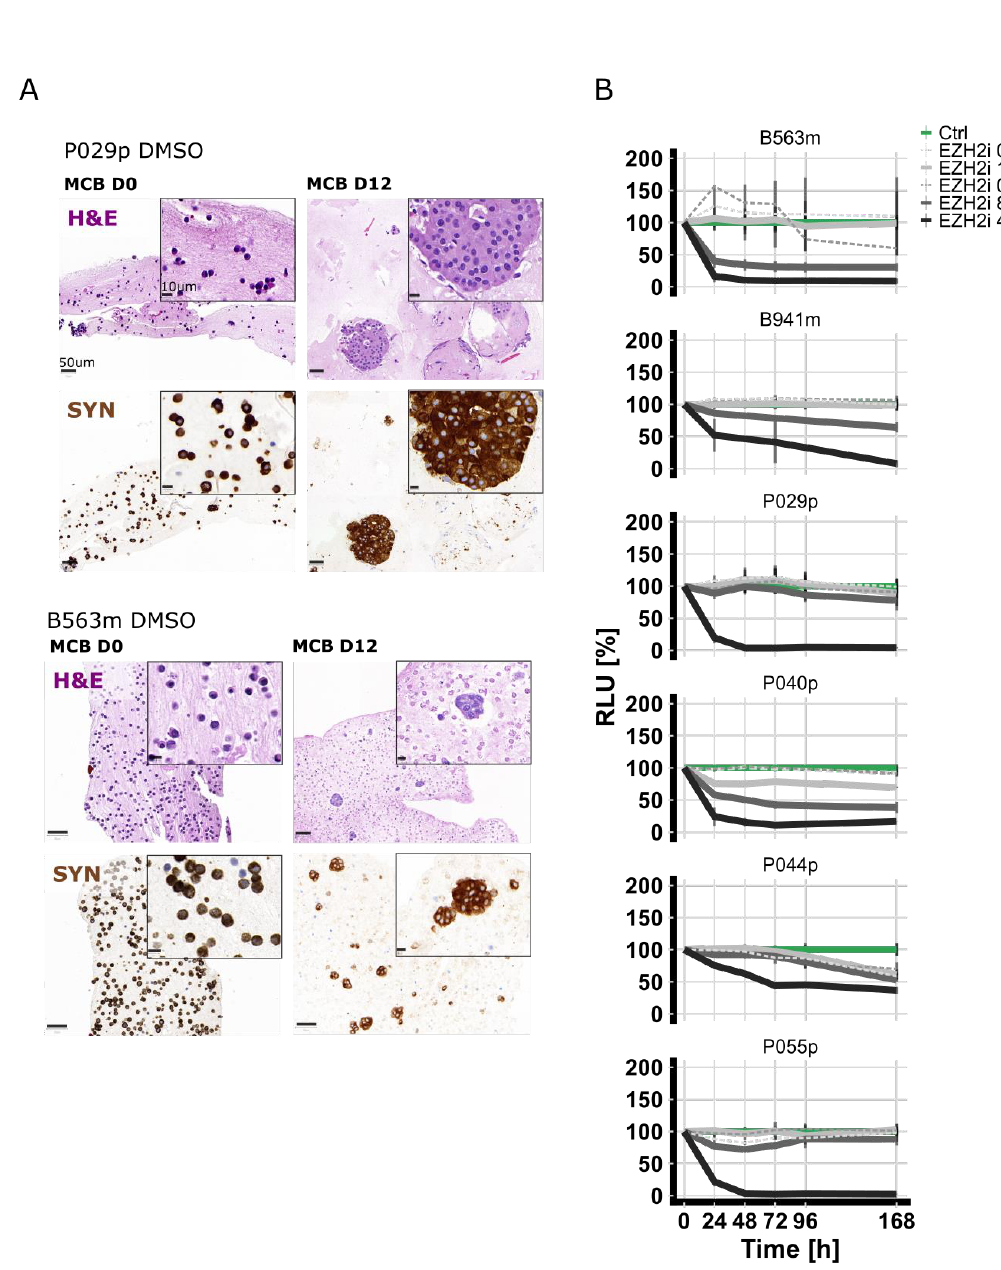
Figure 4. ( A ) In vitro viability curves using the metabolic surrogate assay RealTime-Glo (RTG) in 3D human primary PanNET culture treated with DMSO (control (Ctrl)) and GSK126 for 7 days. Data were first normalized per-well using a RTG baseline measurement for each individual well and then normalized to the average of the corresponding DMSO control of the respective day. Data represent means ± SEM (n = 1 per patient, three technical replicates). RLU, relative luminescence unit. ( B ) Micro-cell-block of two representative samples. IHC of synaptophysin and H&E staining of samples from the day of isolation and DMSO-treated samples 12 days post-isolation.